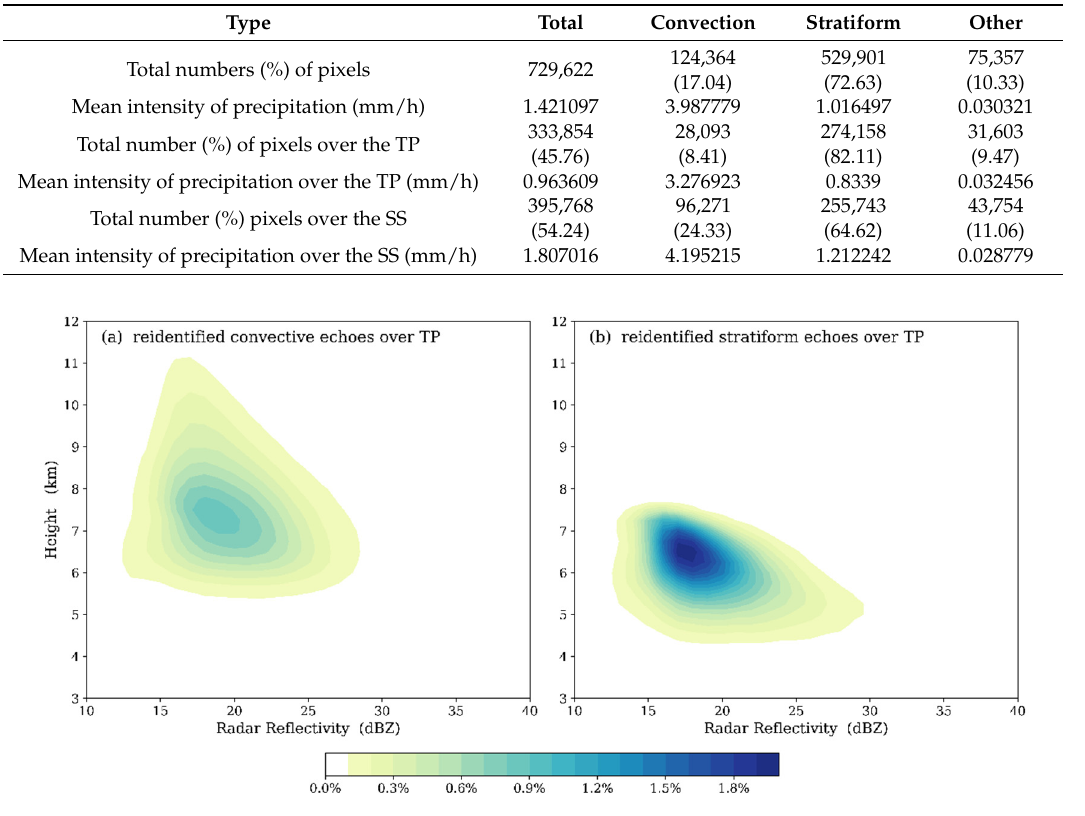
Figure 3. As per Figure 2, but for reidentified ( a ) convective and ( b ) stratiform echoes over the Tibetan Plateau.